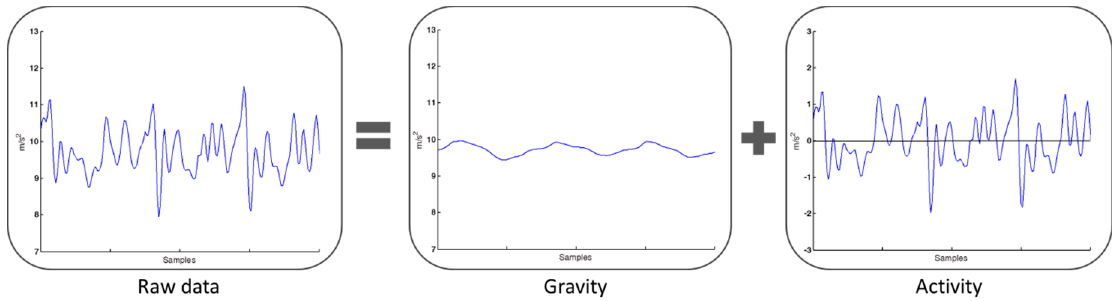
Figure 3. The raw data sensing by accelerometer contains motion acceleration and gravity.